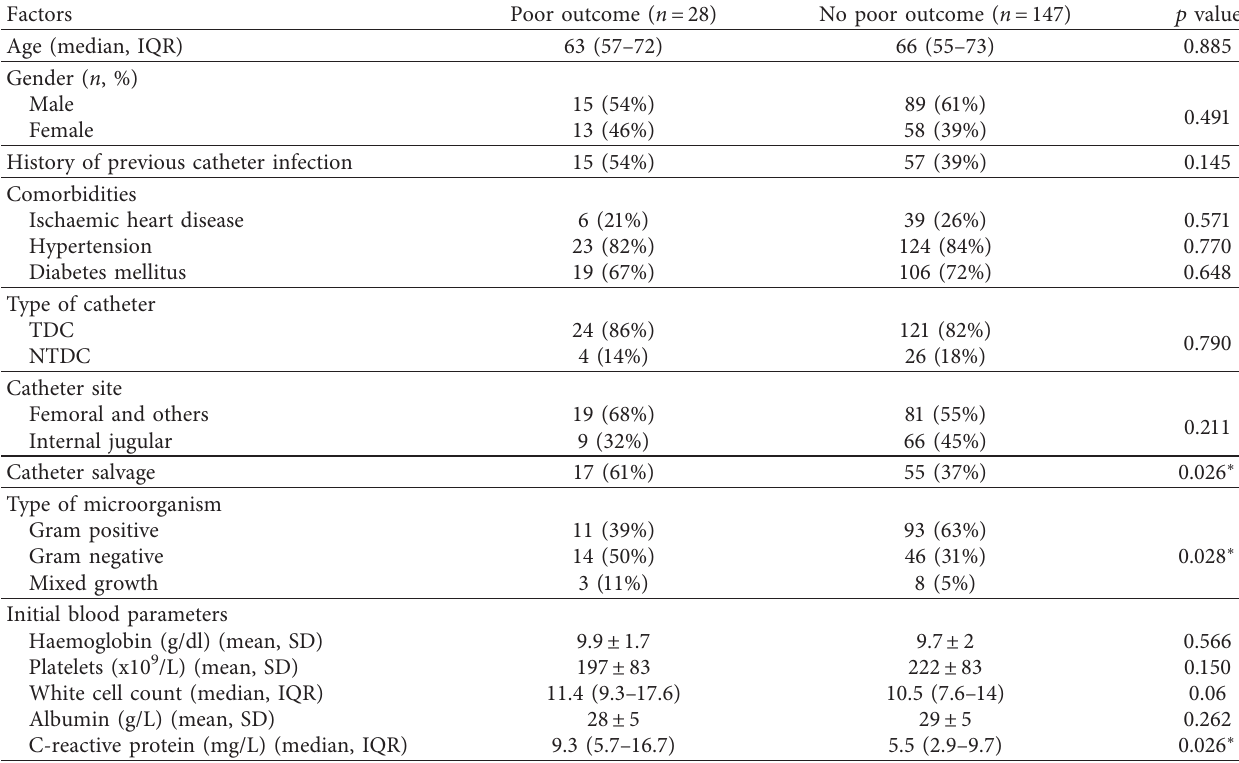
Table 4: Factors associated with poor outcome (shock, death, metastatic infection, and ICU